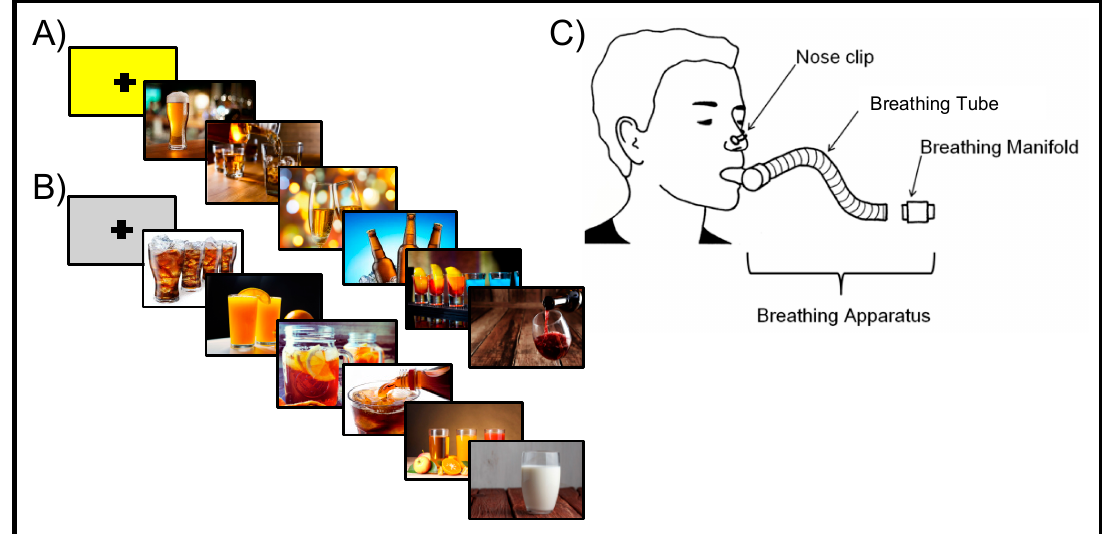
Figure 1. Depiction of the cue reactivity paradigm paired with interoceptive breathing load. ( A ) A yellow fixation screen is presented to the participant, indicating that there is a 1 in 4 chance they will experience the breathing load during the upcoming block of pictures. The fixation screen is immediately followed by 6 images—in this case, alcohol-related cue images. ( B ) A grey fixation screen is presented to the participant indicating that there is no chance they will experience the breathing load during the upcoming block of pictures. The fixation screen is immediately followed by 6 images—in this case, substance-matched comparison images. ( C ) Each participant wears the breathing apparatus while in the fMRI machine. They wear a nose clip to ensure they breathe through the tube only and a breathing manifold is attached at the end of the tube for periods of 40 s as indicated by the paired cue reactivity task.